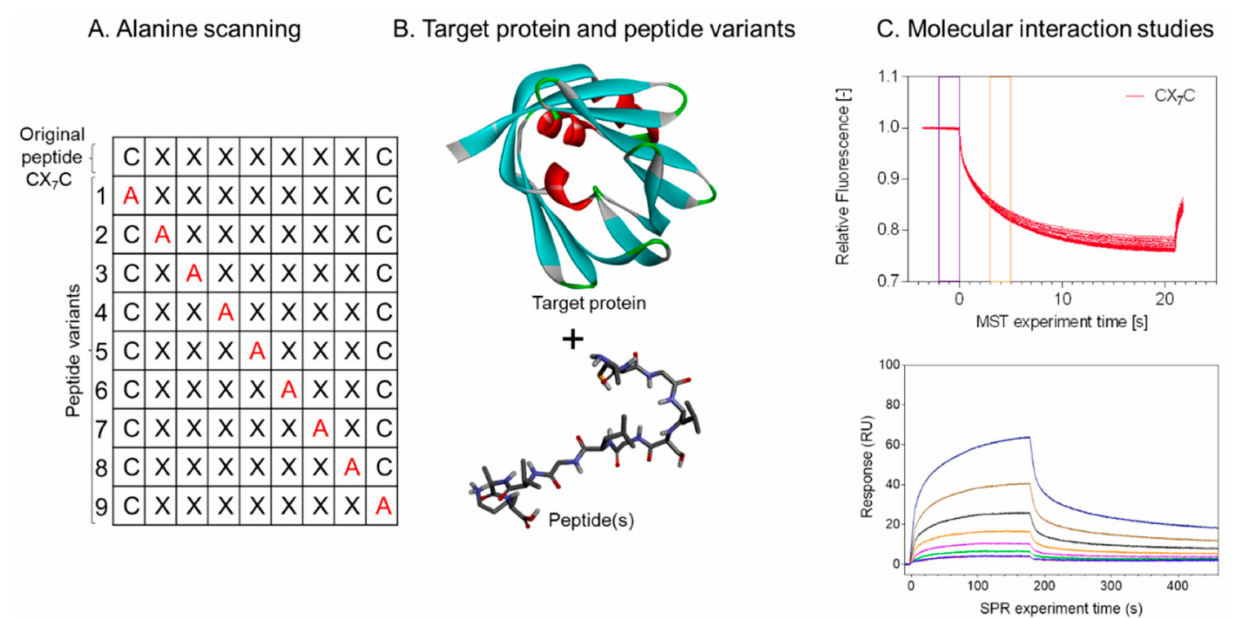
Figure 5. Sequence-activity relationship (SAR) analysis of a cyclic tumor targeting peptide using alanine scan and affinity measurements. ( A ) Scheme shows the sequential substitution of each amino acid residue (X) including the first and the last cysteine residues ( C ) with alanine (A in red) to generate peptide variants, 1–9. ( B ) Production of the recombinant target protein and synthesis of the original peptide and its variants ( C ) microscale thermophoresis (MST) and surface plasmon resonance (SPR) to study the molecular interactions. Figure was generated using prism 9.0.0 (GraphPad software, Inc., San Diego, CA, USA) and discovery studio visualizer v19.1.0.18287 (BIOVIA, San Diego, CA, USA) from Ayo et